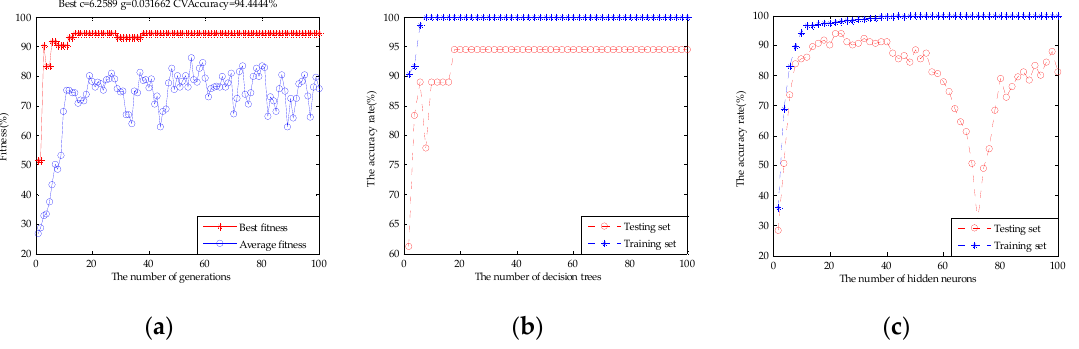
Figure 13. ( a ) The parameter optimization fitness curve of the SVM for the feature screening set by GA-PLS; ( b ) the classification performance of the RF based on the number of decision trees for the feature screening set by GA-PLS; and ( c ) the classification performance of the ELM based on the number of hidden neurons for the feature screening set by GA-PLS. Table 4. Comparison of accuracy based on different classification models using different subsets of variables, based on VIP.